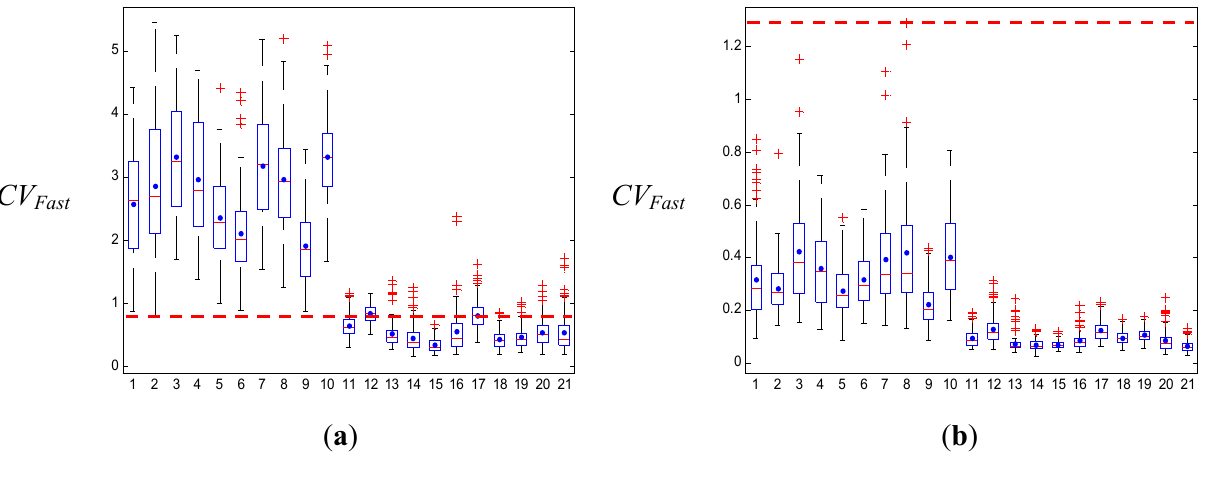
Figure 6. The boxplots of the CV parameter for only four falling ADLs. ( a ) The upper Fast signal, for which the upper falling threshold is 1.25. ( b ) The peak values of the CV Fast signal, for which the upper falling threshold is lower peak values of the CV Fast